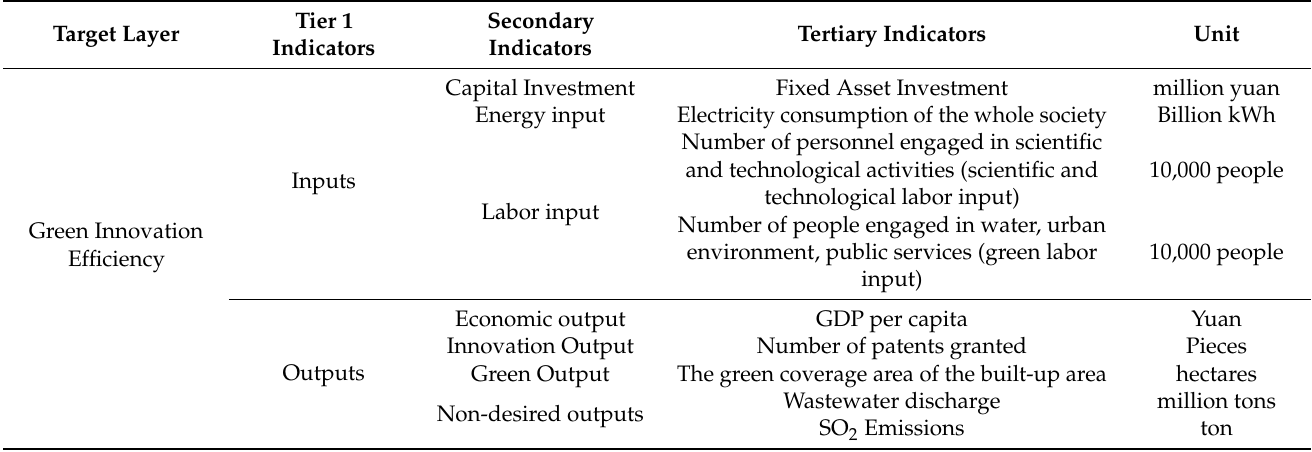
Table 2. Green innovation efficiency index system of resource-based cities.